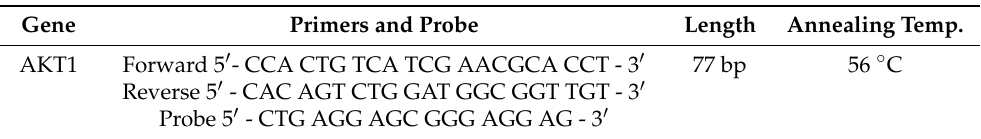
Table A1. Annealing temperature and oligonucleotide sequences used for AKT1 gene amplification on droplet digital PCR.